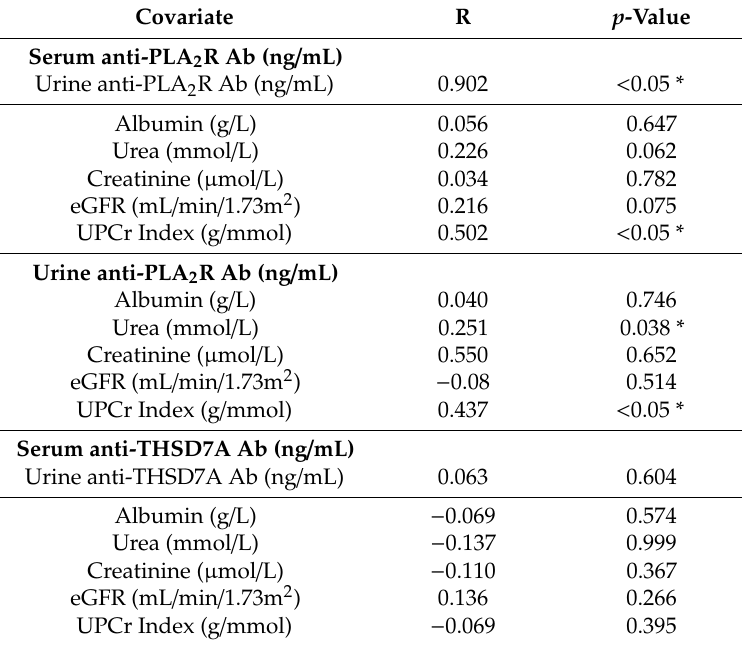
Table 3. Relationship between biomarkers and laboratory